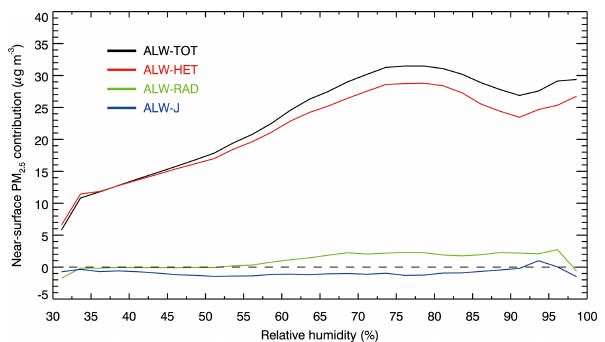
Figure 19. Average contributions to near-surface [PM 2 . 5 ] caused by the ALW-TOT (black line), ALW-HET (red line), ALW-RAD (green line), and ALW-J (blue line) as a function of the RH in NCP from 5 December 2015 to 4 January